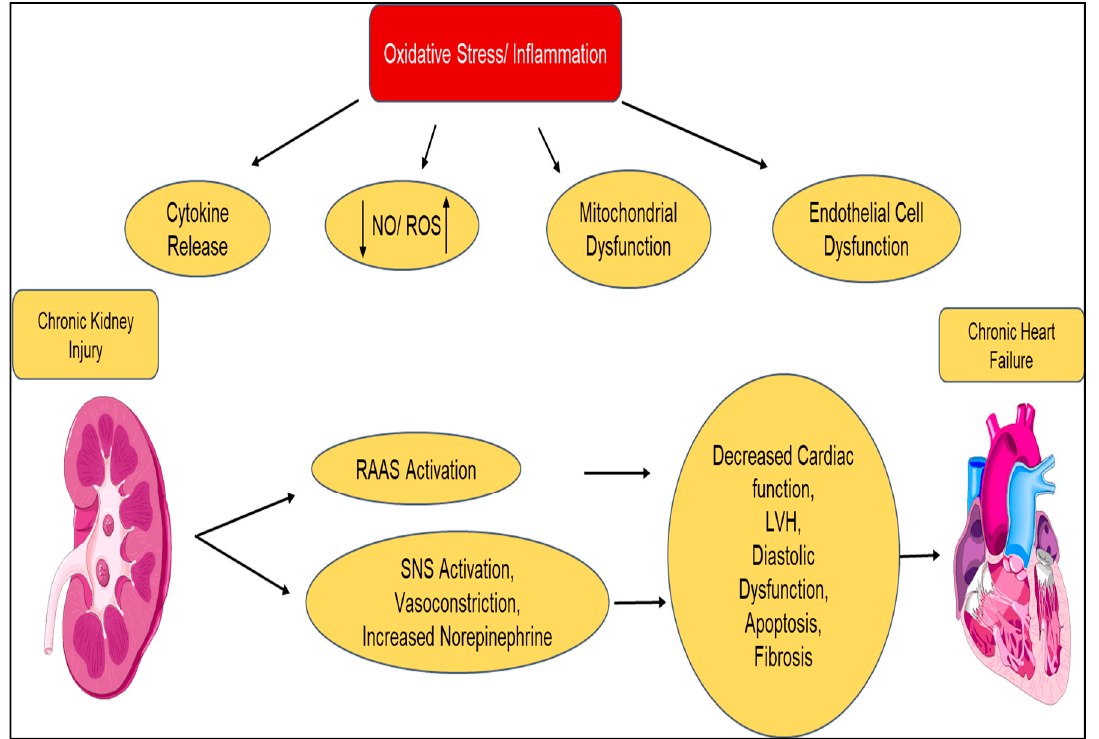
Figure 5. Pathophysiology of renocardiac syndrome (type 4): mechanism involving chronic kidney injury causing worsening heart function. The various causes of CKD, including diabetes and hypertension, accelerate cardiac remodeling, leading to poor cardiac function. This pathway involves RAAS activation and sympathetic nervous system activation.